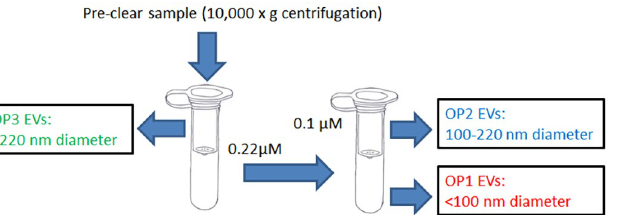
Fig 1. Isolation and separation of EVs by PVDF filtration and ultracentrifugation. The culture medium of PANC-1 cells was pre-cleared by 10,000g centrifugation for 30 min at 4˚C, and the resulting supernatant was passed through a 0.22 μ m PVDF centrifuge filter. The operational 3 (OP3) EVs ( > 220 nm) were trapped in the first filter. The filtered supernatant was then applied to a 0.1 μ m PVDF centrifuge filter. The operational 2 (OP2) EVs (100–220 nm) were trapped in the second filter and re-suspended in PBS from the filter surface. The operational 3 (OP1) EVs ( < 100 nm) in the final supernatant were recovered by ultracentrifugation (100,000g, 70 min at 4˚C). For plasma EV isolation and separation, we started with the isolation of EVs using the Exoquick reagent. The resulting EVs were dissolved in PBS and applied to the filtration and separation process as depicted above.